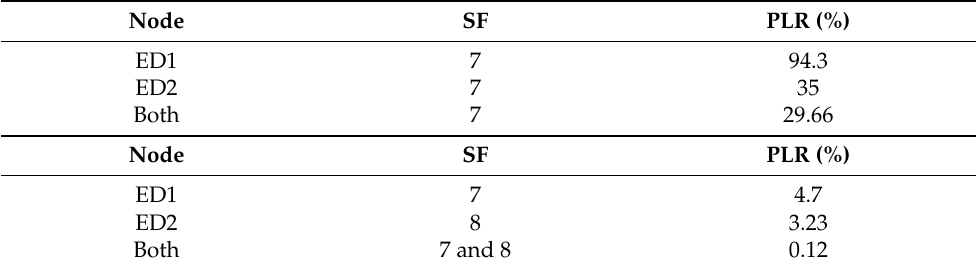
Table 2. Analysis of PLR between SF7 and SF8.